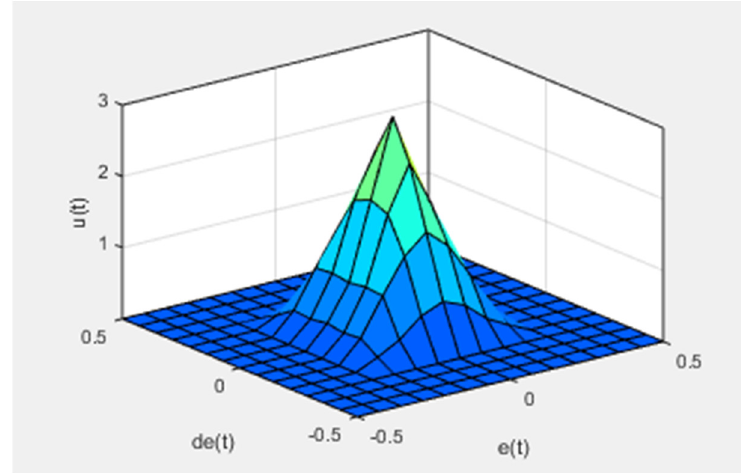
Figure 19. Control surface of the integrative action.